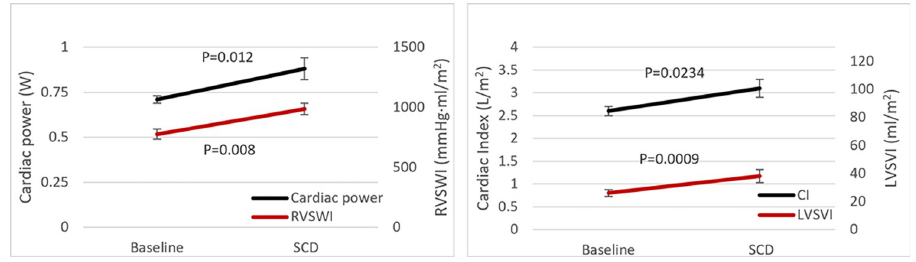
Fig 5. Effect of SCD treatment on cardiac parameters in enrolled subject. Left panel. Improvements in Cardiac Power Output (CPO) and Right Ventricle Stroke Work Index (RVSWI) from Baseline (pre-SCD treatment, Day-6 to Day-1) and during SCD treatment (Day1-6). Right panel. Improvements in Cardiac Index (CI) and Left Ventricle Stroke Volume Index from Baseline and during SCD treatment.